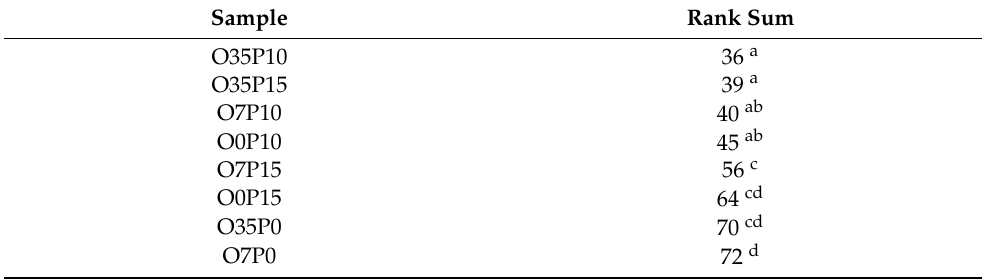
Table 5. Rank sum for green Saba banana flour-based cakes obtained in Ranking Test. Sample Rank Sum O35P10 36